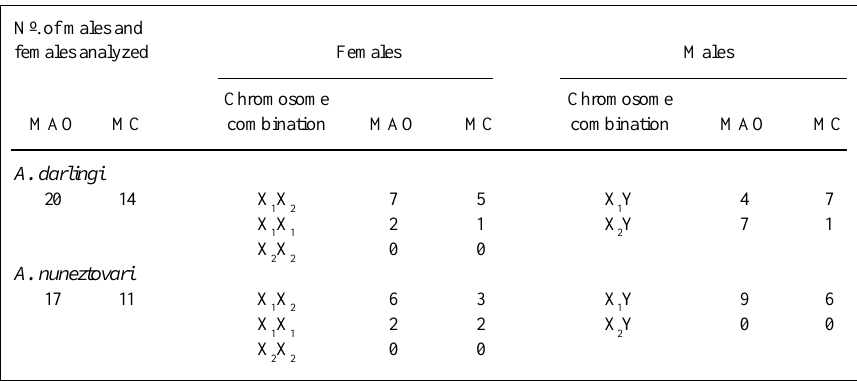
Table I - X and X chromosomes in females and males of Anopheles darlingi and Anopheles 1 2 nuneztovari populations from Manaus (MAO) and Macapá (MC). Nº. of males and females analyzed Females Males Chromosome Chromosome MAO MC combination MAO MC combination MAO